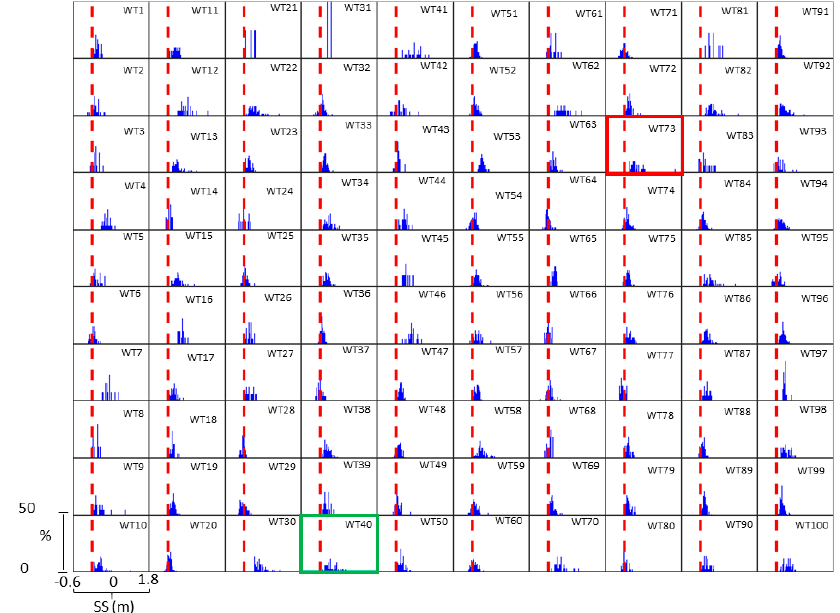
Figure A4. SD4 inferred distribution of daily maximum storm surge (SS) for each SD4 weather type (Figure A3). The dashed red line refers to the value of 0 m. Calibration period: years from 2000 to 2014, excluding 2012, which is the validation period. WT73 and WT 40 contain the Xynthia (red rectangle) and Joachim (green rectangle) storm surge response in its associated distribution of SS.